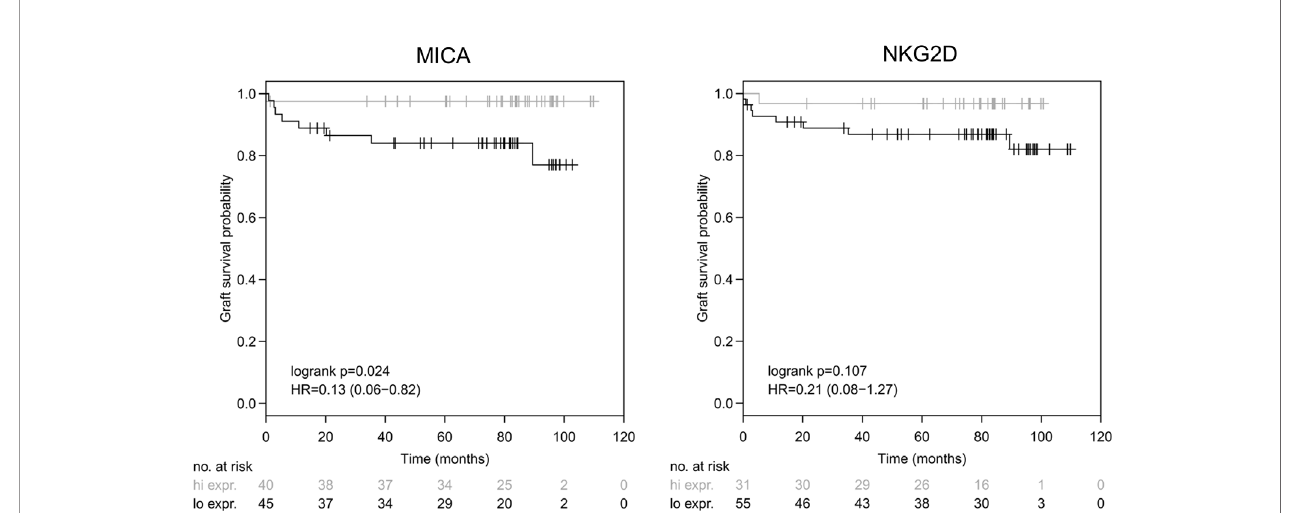
FIGURE 4 | Intragraft mRNA expression of MICA correlates with long-term survival. MICA mRNA illustrates a signi fi cant correlation with graft survival following LT (logrank p = 0.024) after 10 years of follow-up [left], whereas NKG2D showed no signi fi cant correlation with graft survival (logrank p=0.107) [right]. Dichotomization cutoff for normalized expression was de fi ned at the maximal Harrel ’ s concordance index (MICA, C max = 0.68, cutoff = 0.071 and NKG2D, C max = 0.63, cutoff = 0.1081), whereby high expression was de fi ned > cutoff and low expression ≤